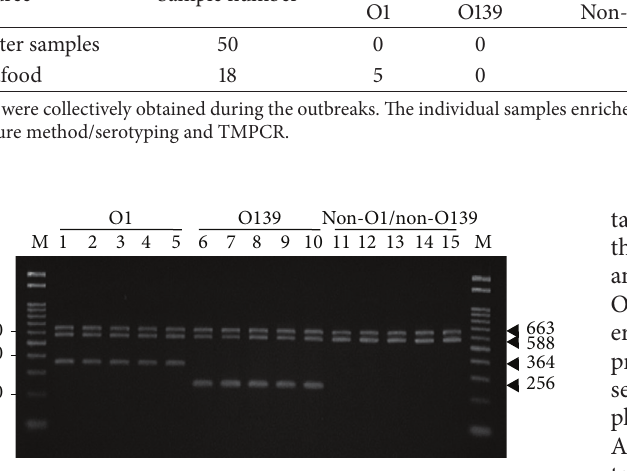
Figure 4: Agarose gel electrophoresis of the O serogroup-specific TMPCR and 16S rDNA PCR profiles using representative V. cholerae